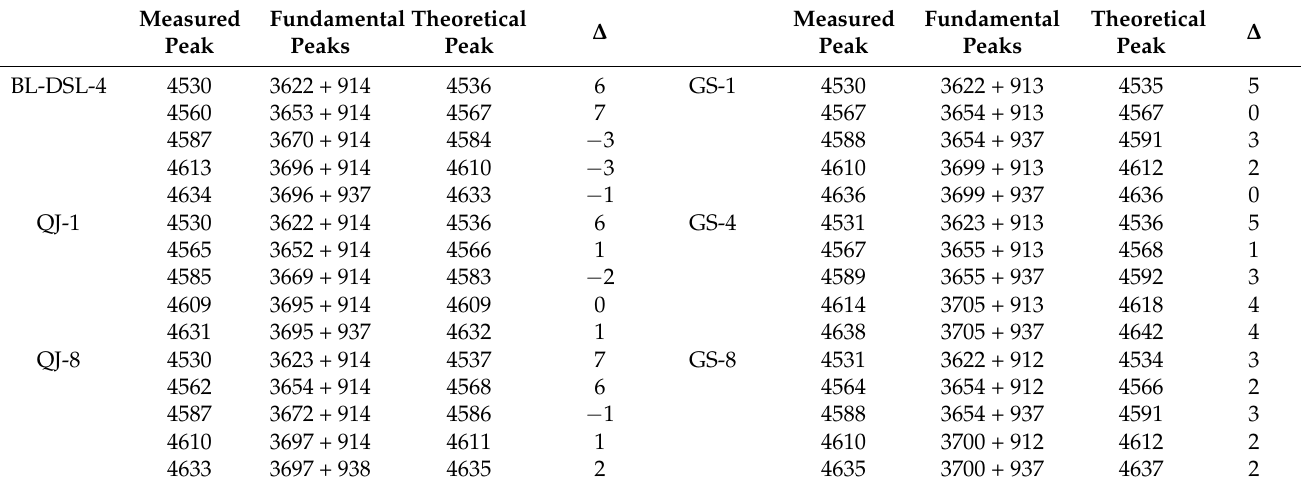
Table 4. The major NIR bands in 4500~4700 cm − 1 for related samples and their corresponding MIR peaks (cm − 1